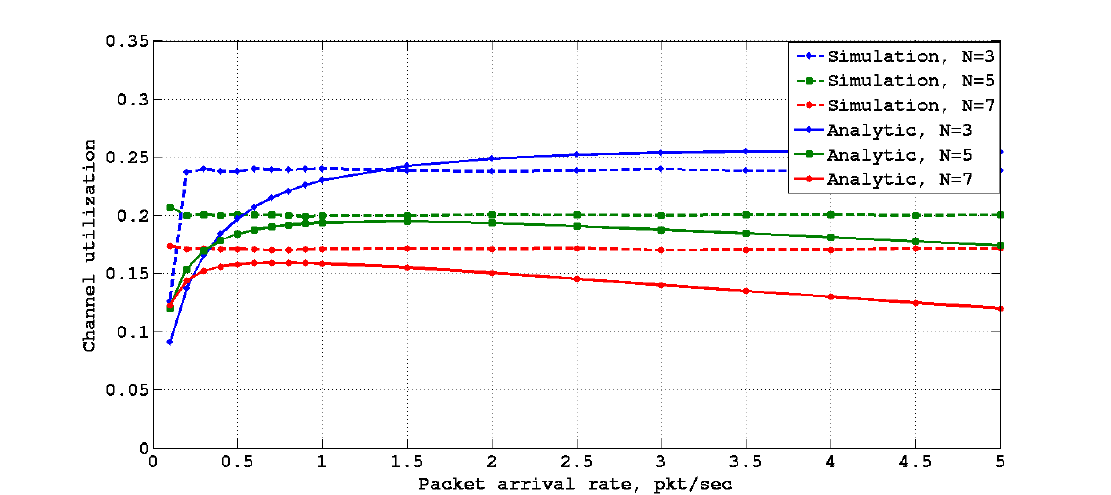
Figure 14. Simulation vs. quantitative analysis for the proposed